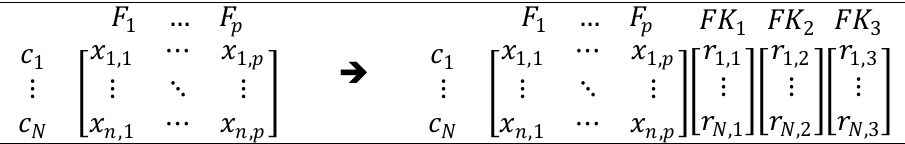
Figure 8. Critical differences plot of the pairwise Nemenyi comparison test for the cut-off (threshold) adaptation experiment.